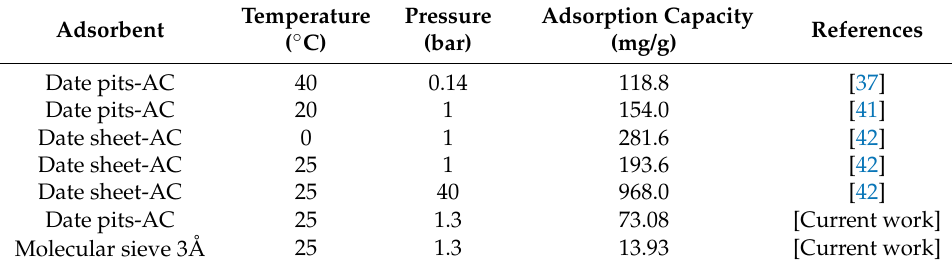
Table 6 summarized the adsorption capacity reported under different operating conditions for date-based activated carbon and molecular sieve 3Å. Table 6. CO 2 adsorption capacity of various